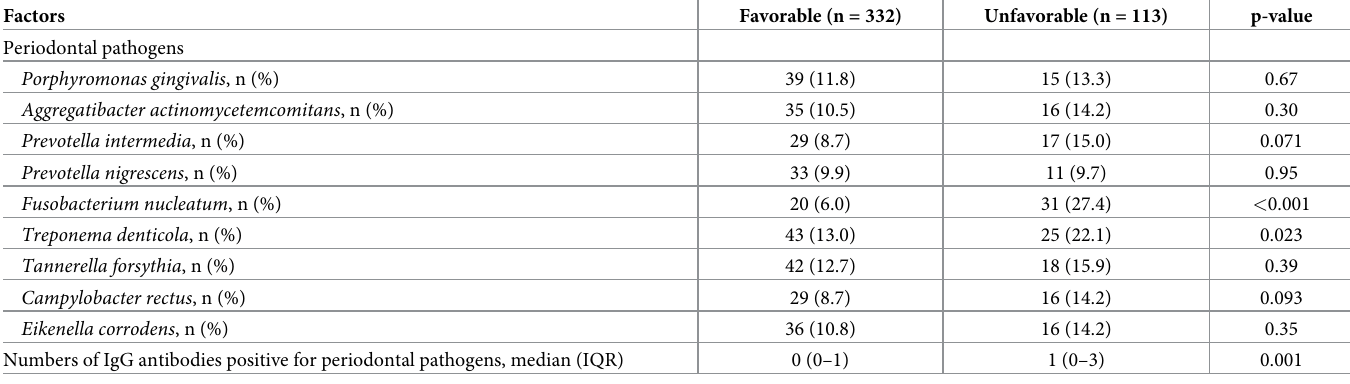
Table 3. Univariate analysis of antibody titers to periodontal pathogens (positive for periodontal pathogens) to determine associations with unfavorable outcome.